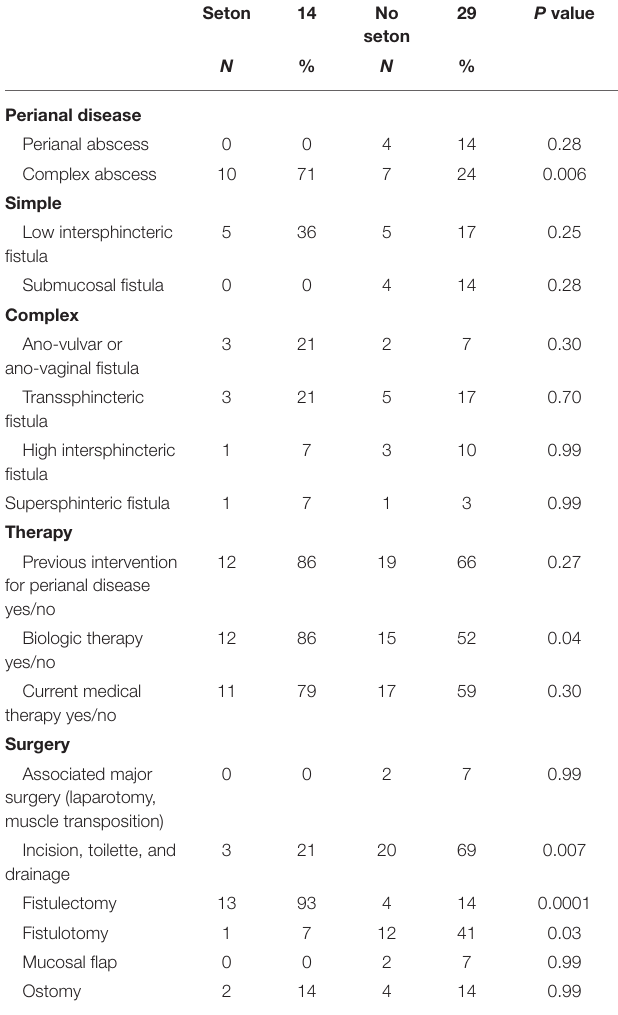
TABLE 2 | Demographic data, anatomical description, AGA classification, and clinical history of the 43 patients with perianal CD who completed the survey.